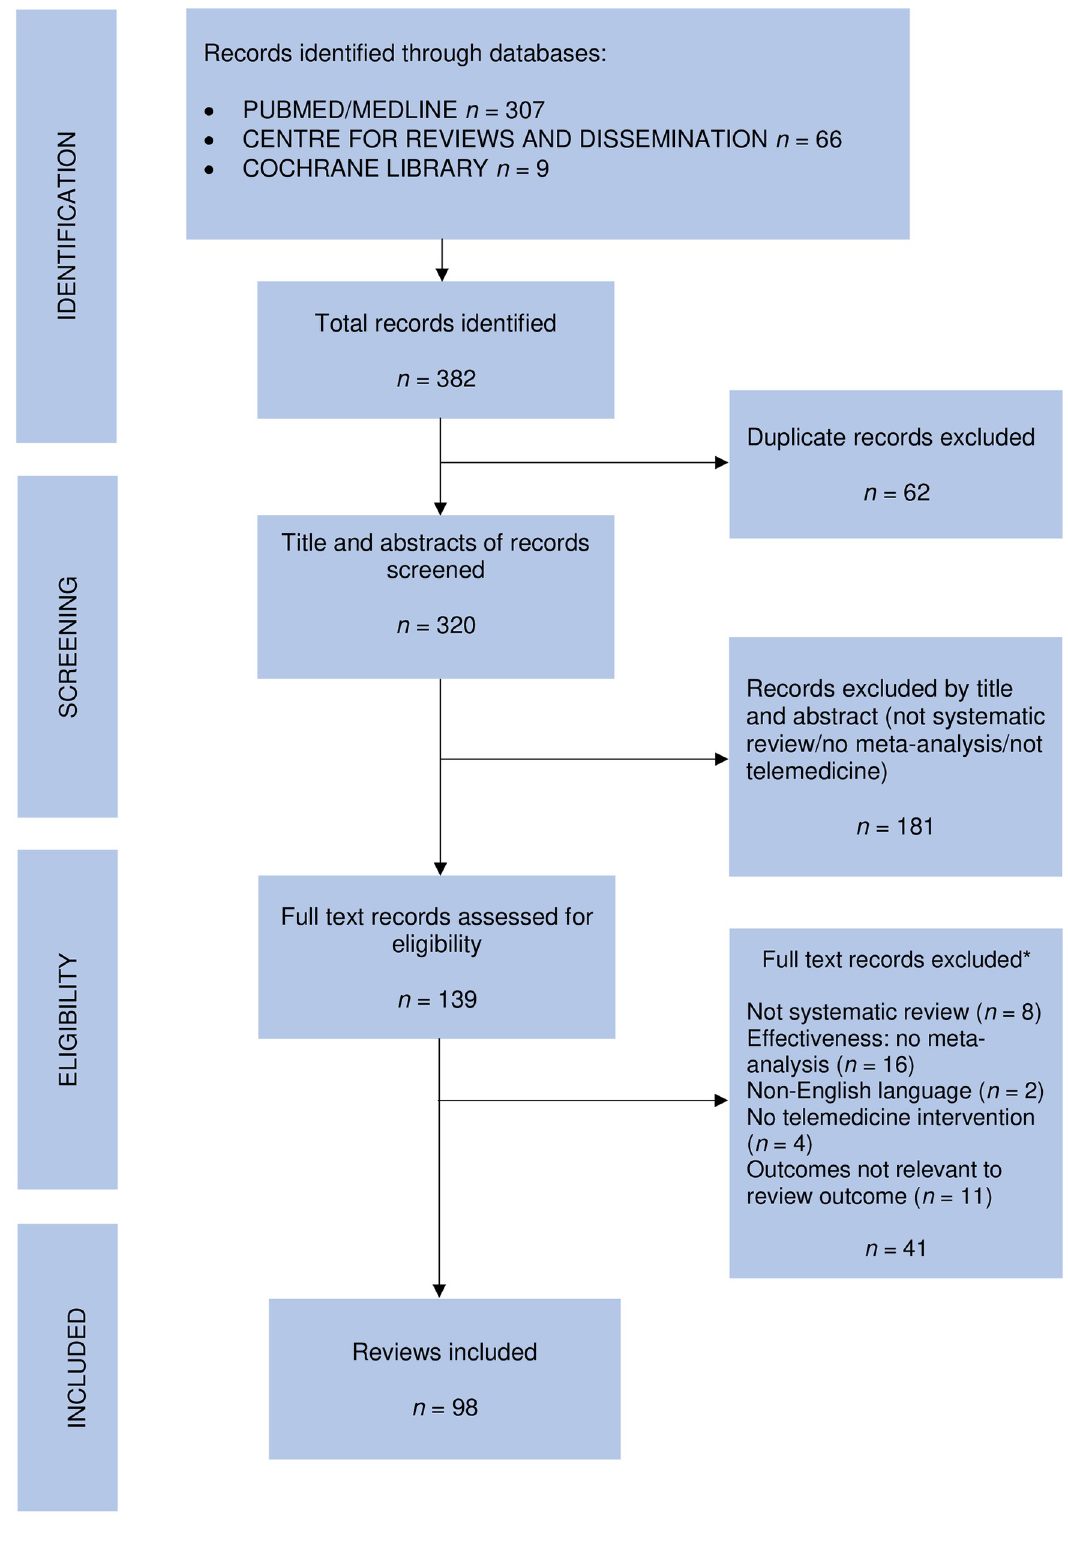
Fig 1. Prisma flow